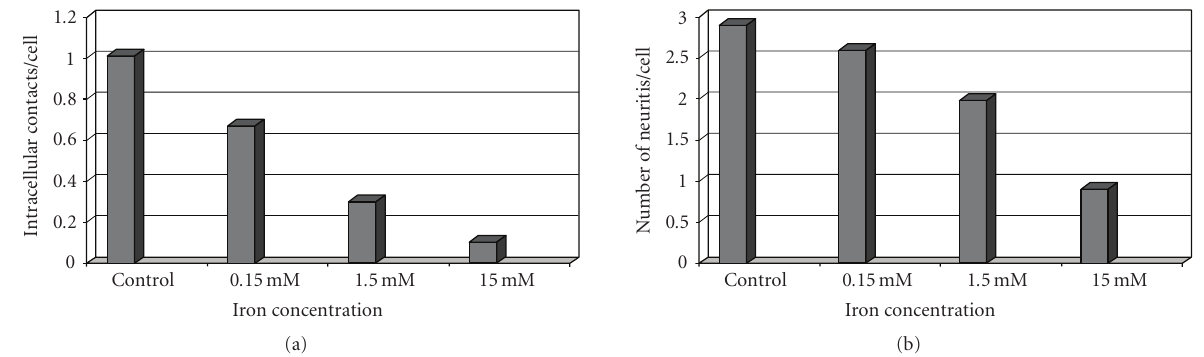
Figure 1: (a) Number of intracellular contacts and (b) formation of neuritis in nano-Fe 2 O 3 treated PC12 nerve cells.